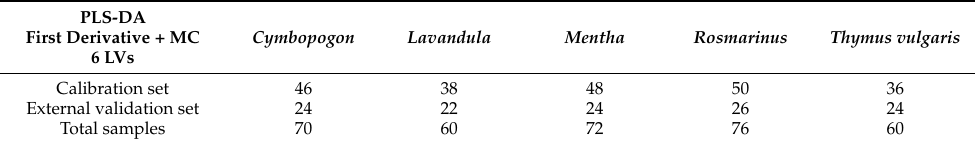
Table 5. Number of samples in the calibration and external validation set. The last raw reports the total number N of samples per class.